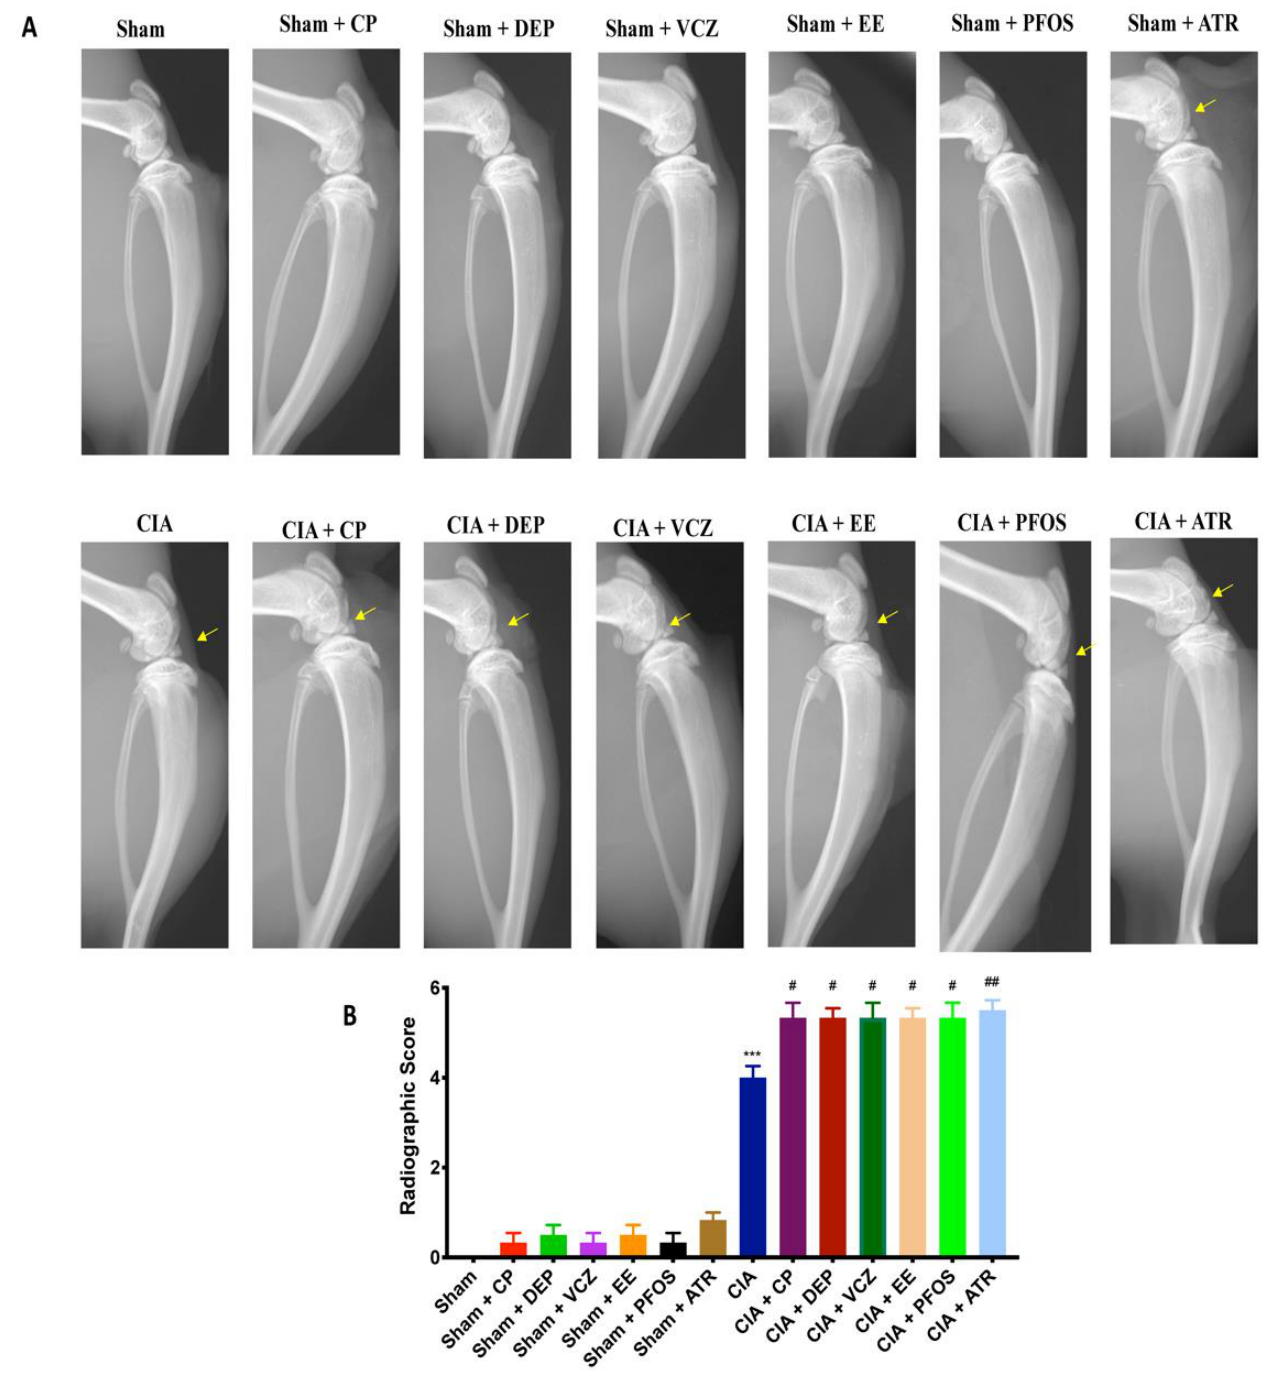
Figure 4. Radiography of knee joint from all groups ( A ); radiographic score ( B ). *** p < 0.001 vs. sham; # p < 0.05 vs. CIA; ## p < 0.01 vs. CIA.